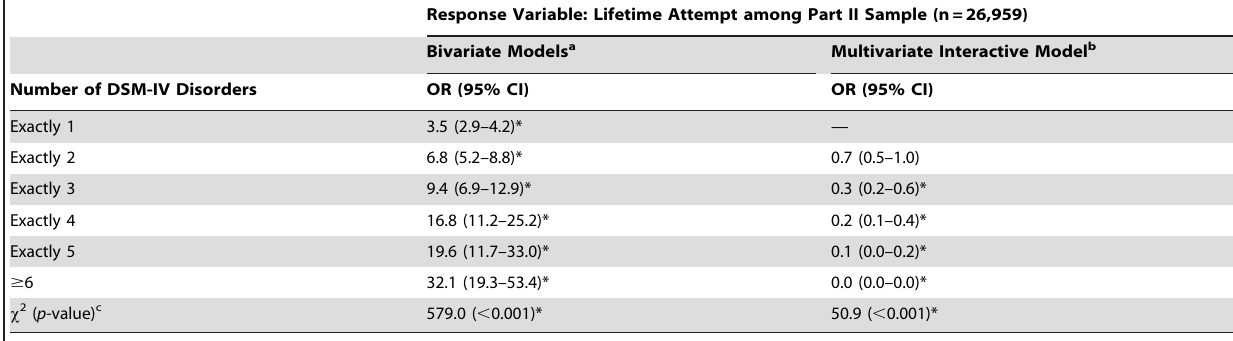
Table 5. Survival models of the associations between number of prior DSM-IV disorders and a subsequent suicide attempt— developing